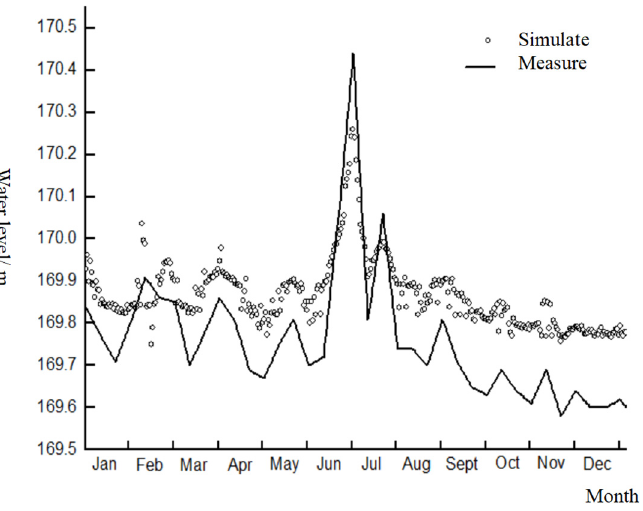
Figure 3. Water level simulation results of hydrological station in Beikouqian.